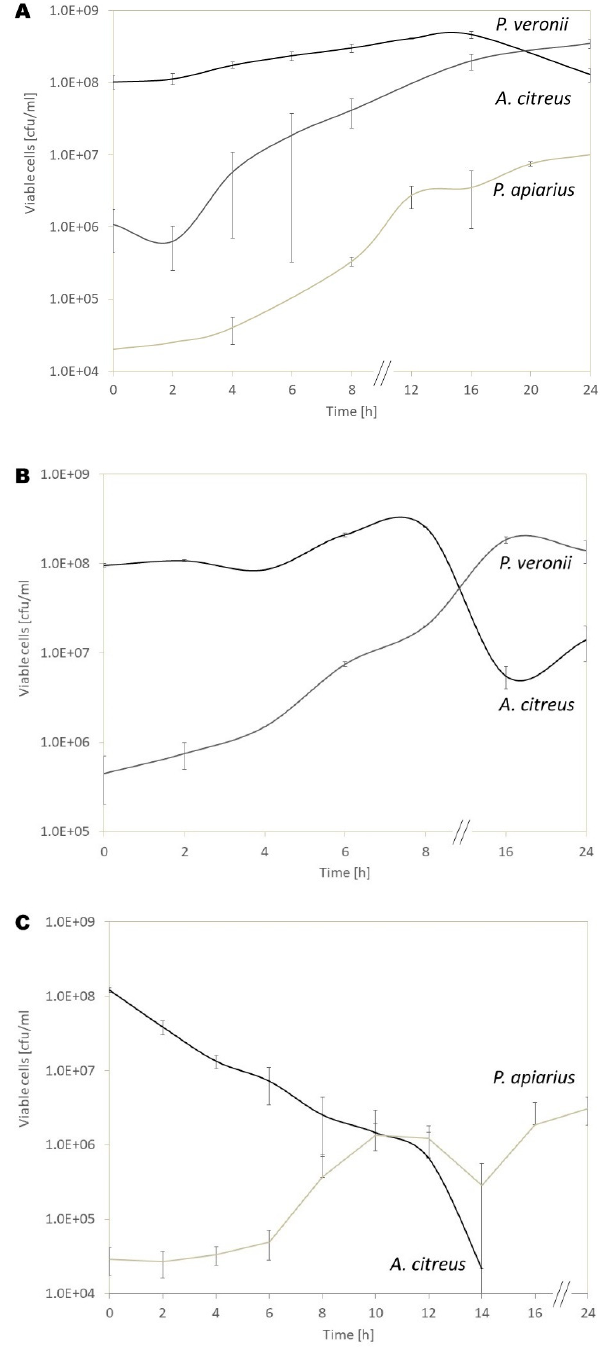
Figure 2. Growth curves of pure and co-cultures in DNB (tenfold diluted nutrient broth) for 24 h at 30 °C and 130 rpm. The initial OD 500 of A. citreus was set to 0.2, while it was set to 0.05 for P. veronii and P. apiarius ( A ) Growth of the three separate control cultures of A. citreus SBUG 321, P. veronii SBUG 1927 and P. apiarius SBUG 1947 ( B ) Growth of P. veronii SBUG 1927 and A. citreus SBUG 321 in a co-culture ( C ) Growth of P. apiarius SBUG 1927 and A. citreus SBUG 321 in a co-culture.